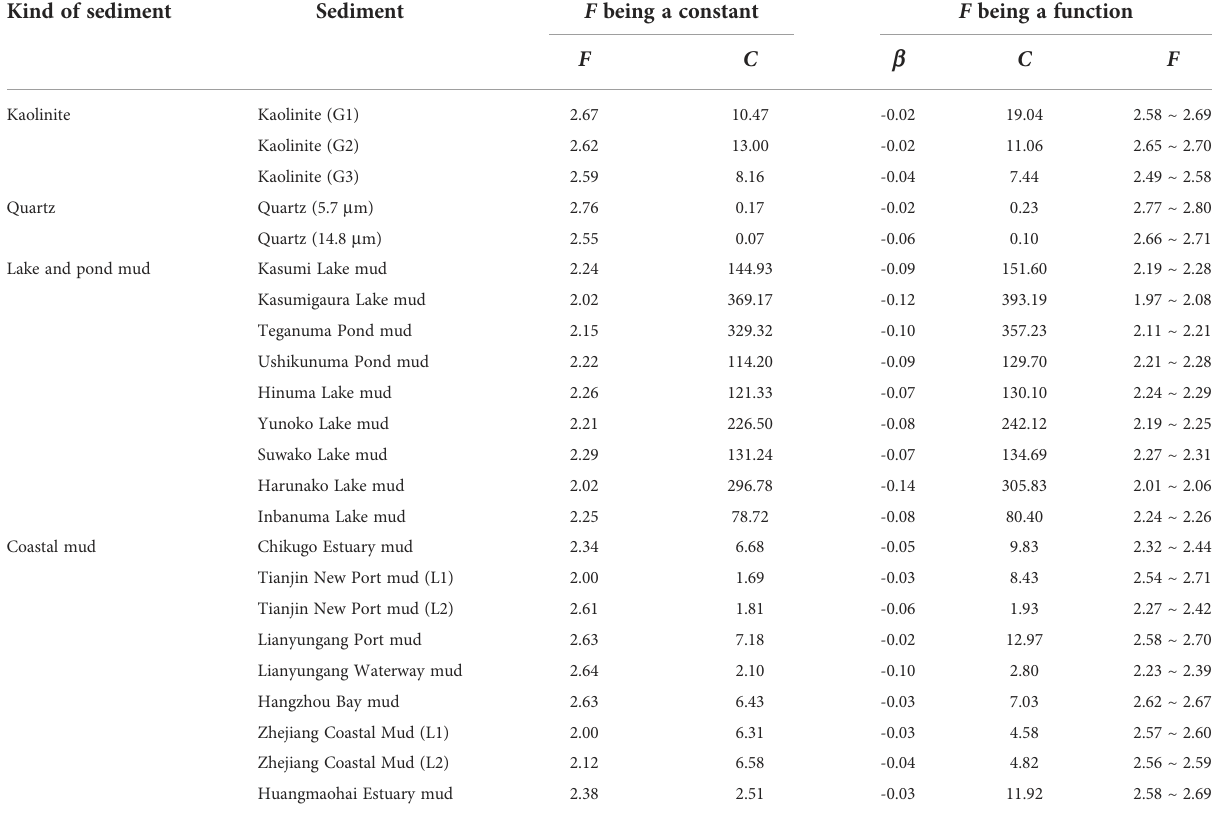
TABLE 2 Application results of the developed formula in different cohesive sediments.